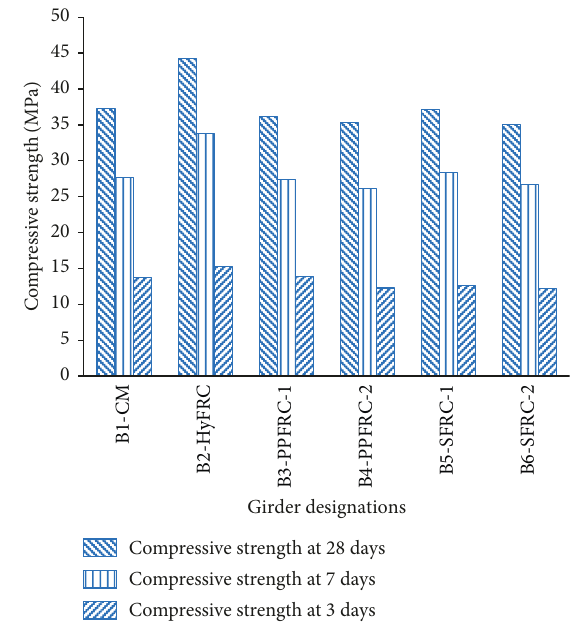
Figure 6: Average compressive strength at different curing